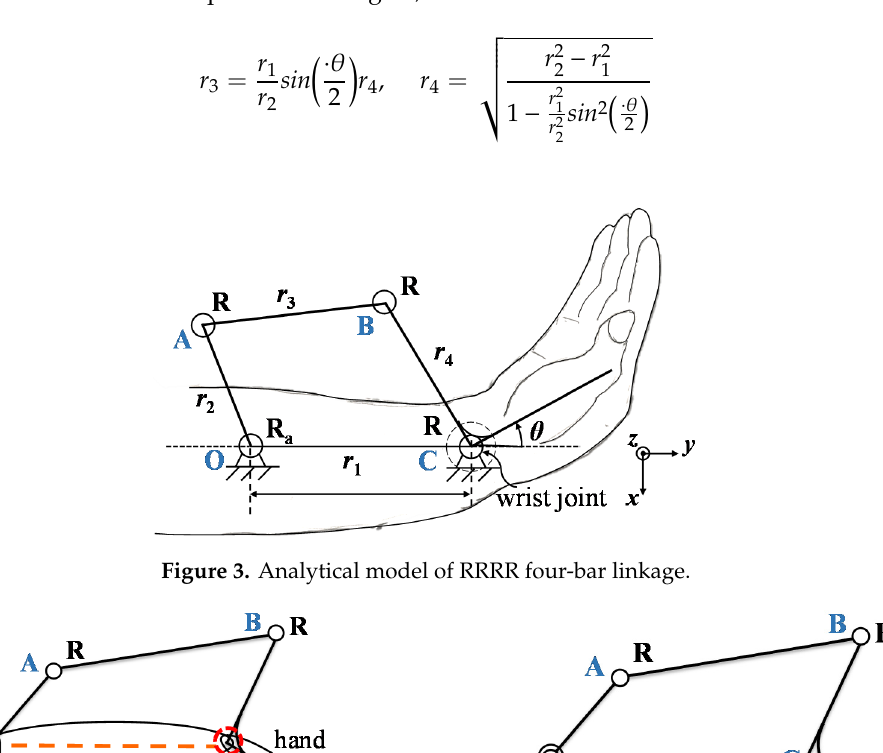
Figure 4. ( a ) Exoskeleton attached to the forearm; ( b ) Exoskeleton detached from the forearm.